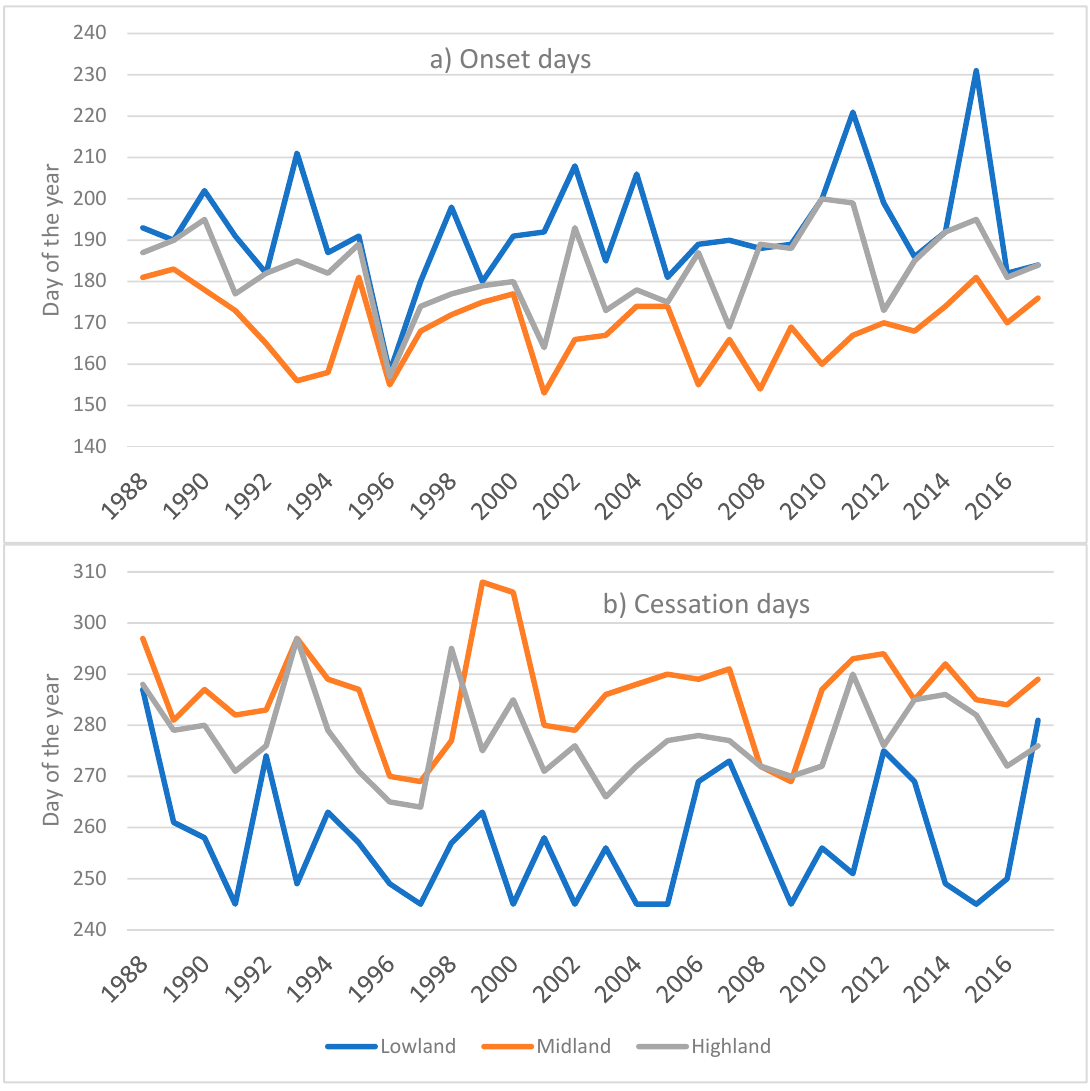
Figure 5. Trends of onset and cessation days of rainfall by agro-ecological